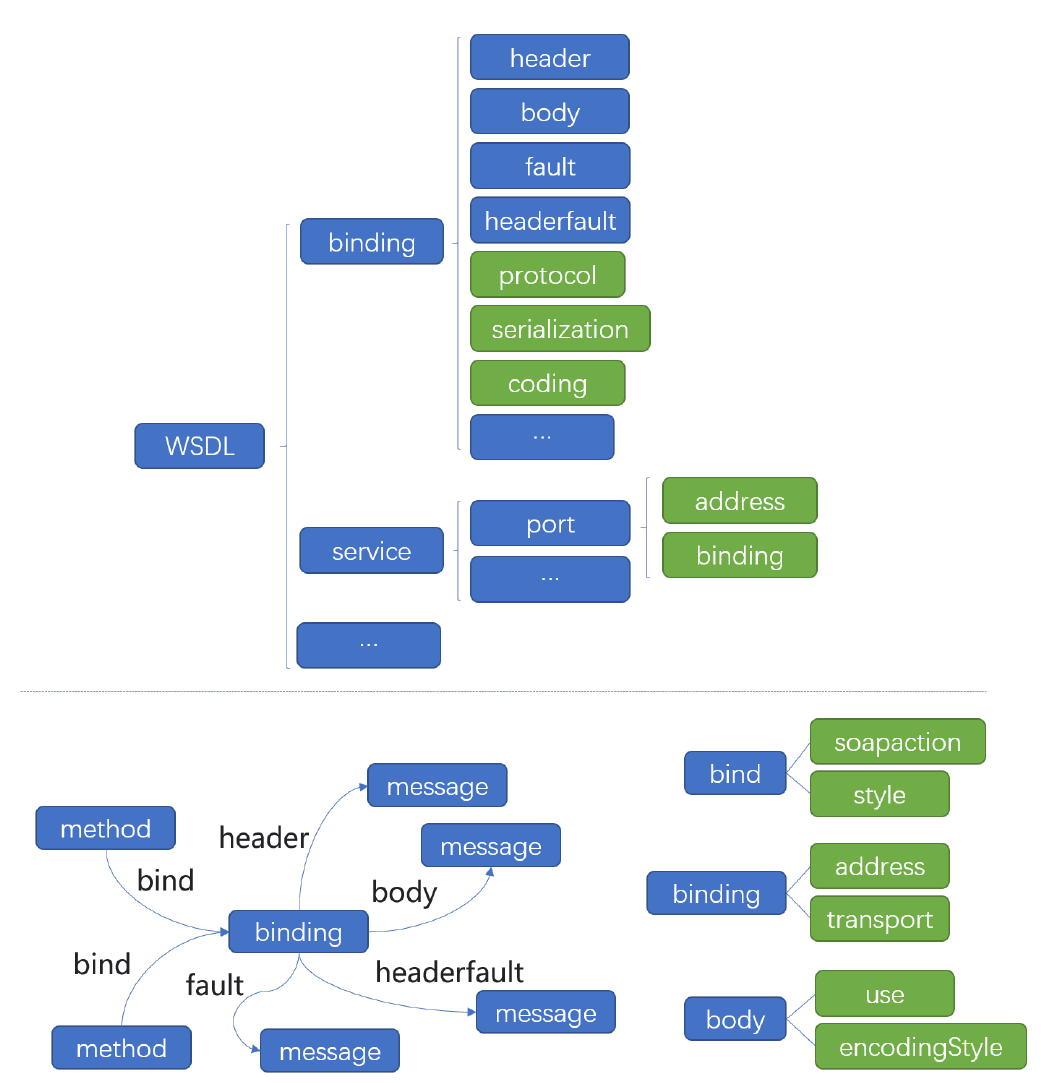
Figure 3. The binding and service elements expressed in WSDL are located at the top. The binding and relationship defined between binding and other ontology in service knowledge graph are shown below. The green box indicates that the content is an attribute, and the blue indicates element (in WSDL) or ontology (in service knowledge graph).